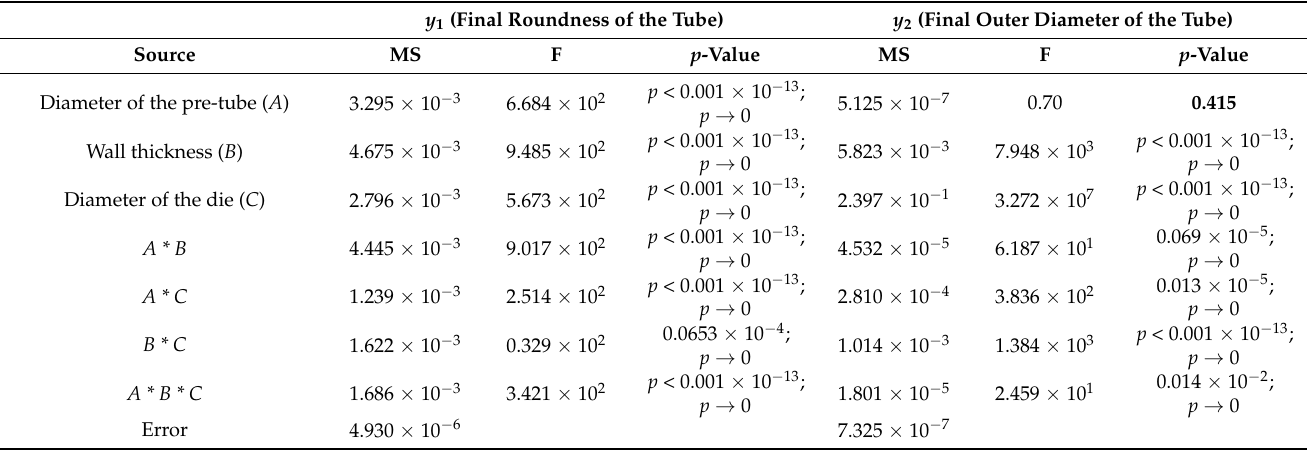
Table 11. Summary of key ANOVA values for the response variables y 1 and y 2 . y 1 (Final Roundness of the Tube) y 2 (Final Outer Diameter of the